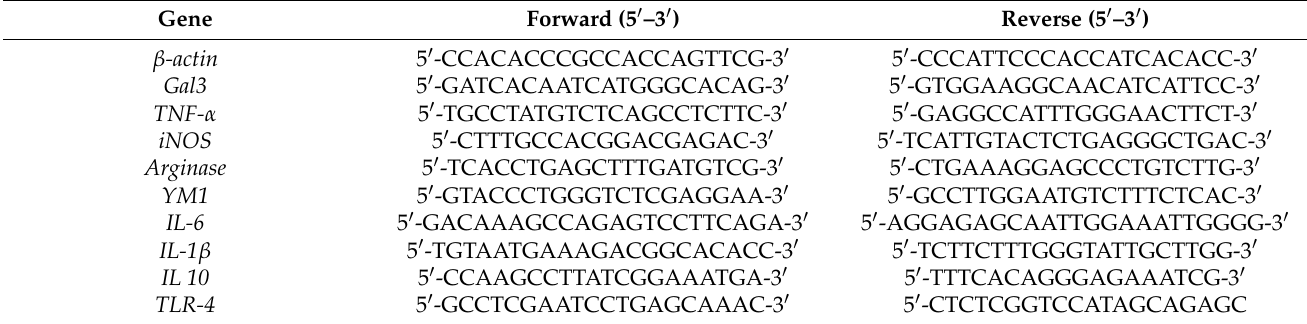
Table 2. Sense and antisense sequences of the primers used for the analysis of mRNA expression by